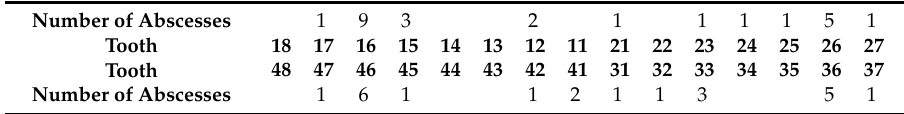
Table 7. Number of root abscesses per